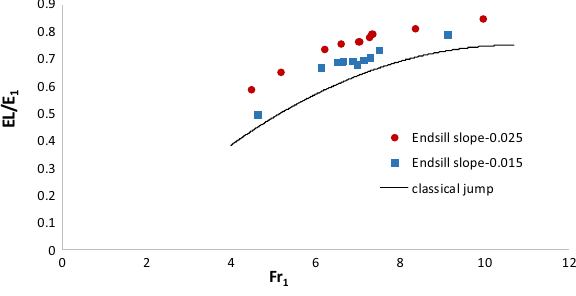
Fig. 7 The relative energy dissipation E